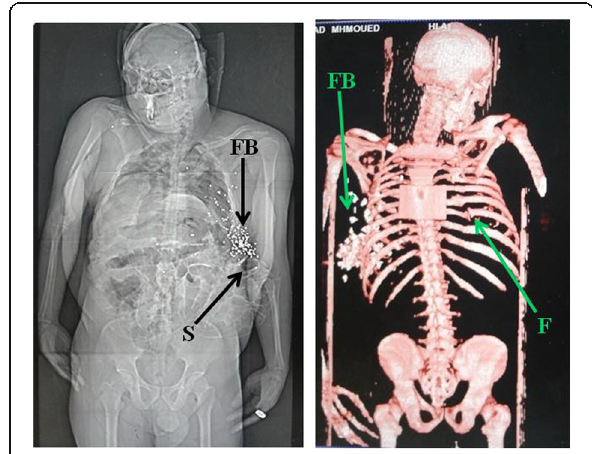
Fig. 4 Multiple gunshot injuries. a PMCT scanogram image showing multiple small, dense metallic foreign bodies (FB; bullet fragments) in the left lung and inside the thoracic cavity and left subcutaneous surgical emphysema (S). b PMCT-3D-volume rendering image showing comminuted fracture (F) of the left ribs (5th, 6th, and 7th) in the chest and multiple, small, dense, metallic foreign bodies (FB; bullet fragments)